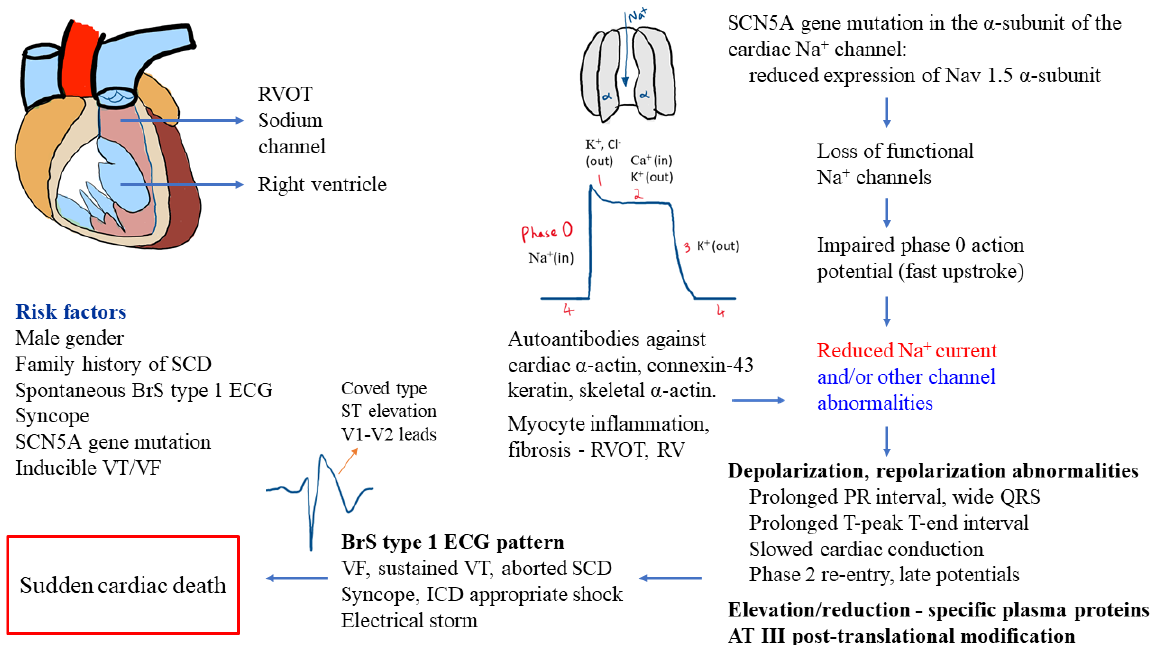
Figure 1. Overview of pathomechanisms involved in Brugada syndrome [9–12,21,22,24–27].